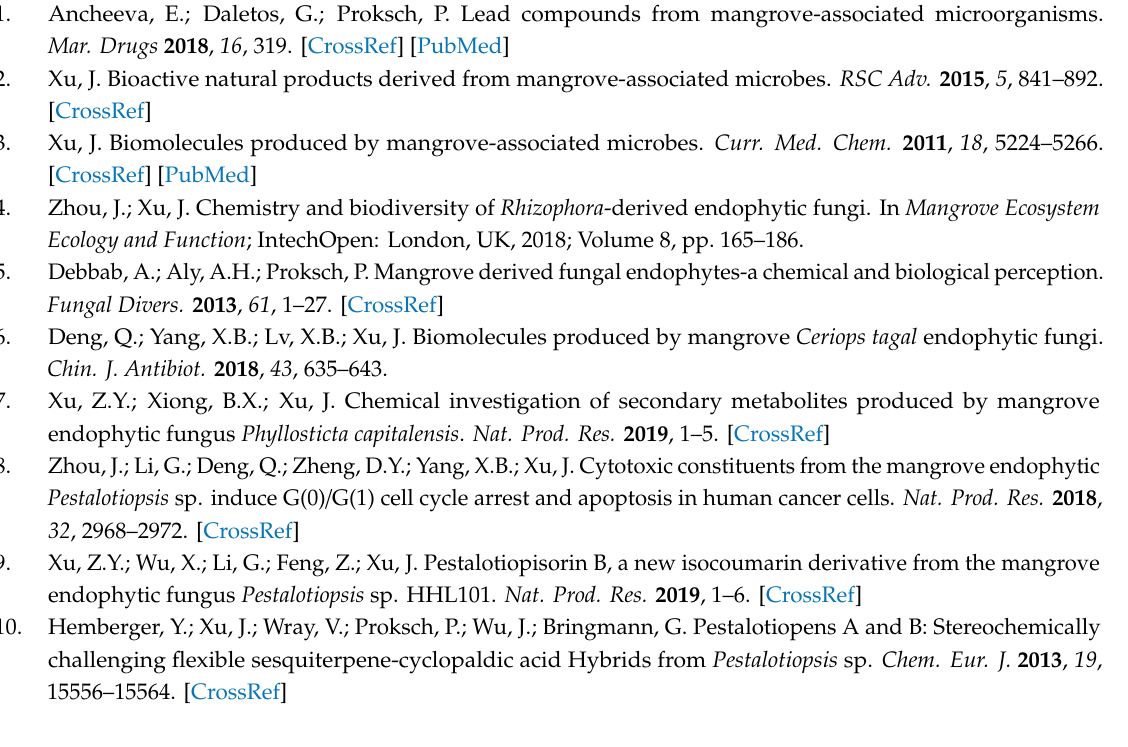
Figure S5. HMQC of cytospyrone ( 1 ); Figure S6. HMBC of cytospyrone ( 1 ); Figure S7. ROESY of cytospyrone ( 1 ); Figure S8. HR-ESI-MS of cytospyrone ( 1 ); Figure S9 CD spectrum of cytospyrone ( 1 ); Figure S10. 1 H-NMR